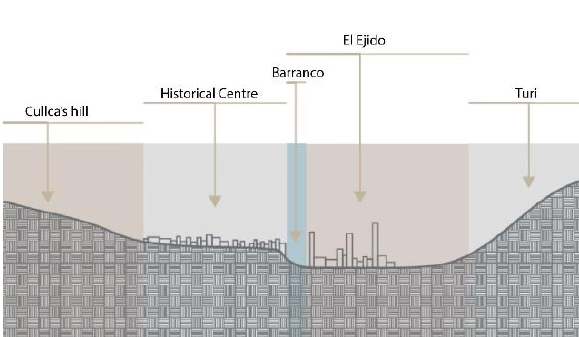
Figure 4. Topography of the city of Cuenca. Source: Criollo, Herás, Macancela, Washima,